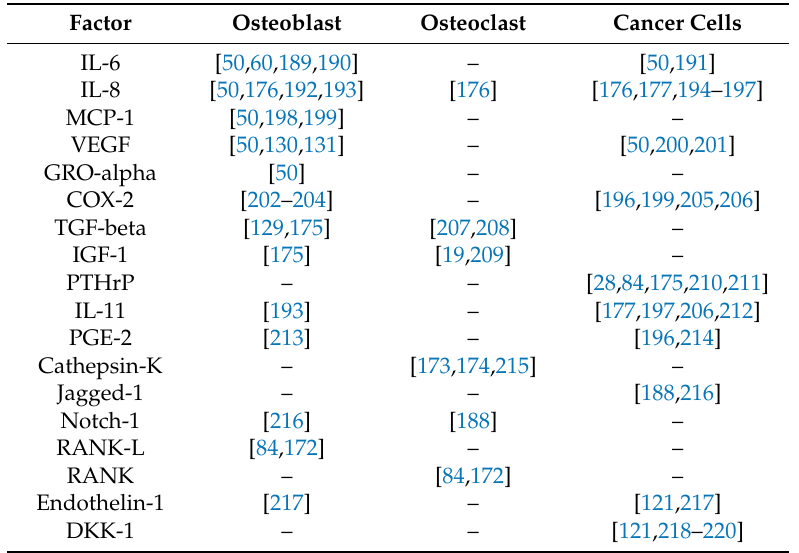
Table 1. Sources of important factors produced by osteoblasts, osteoclasts, or bone metastatic cancer cells in the ‘vicious cycle’ of bone